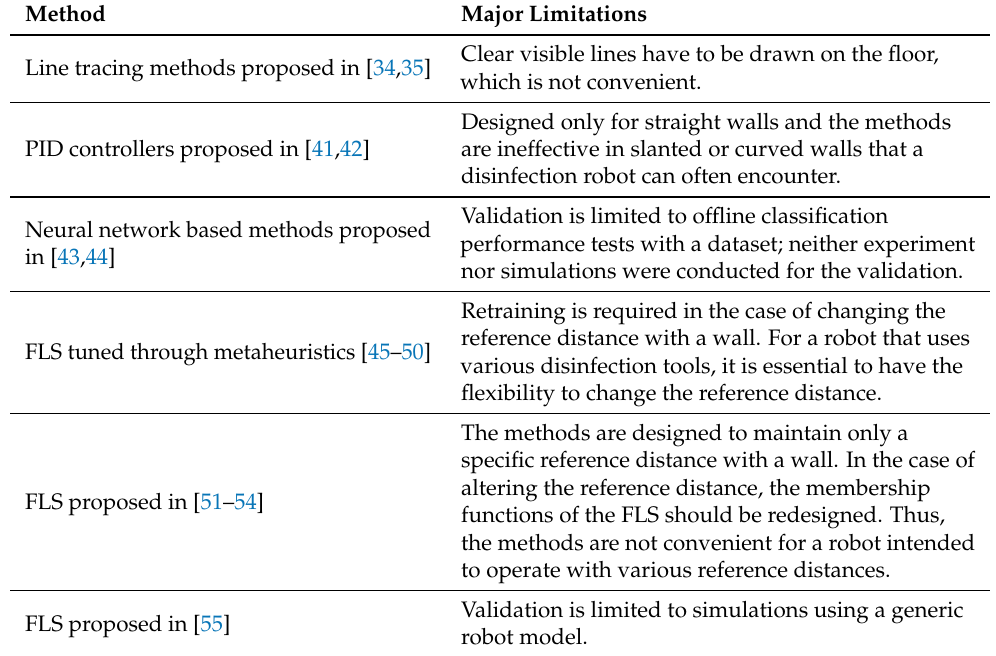
Table 1. Limitations of the existing wall following